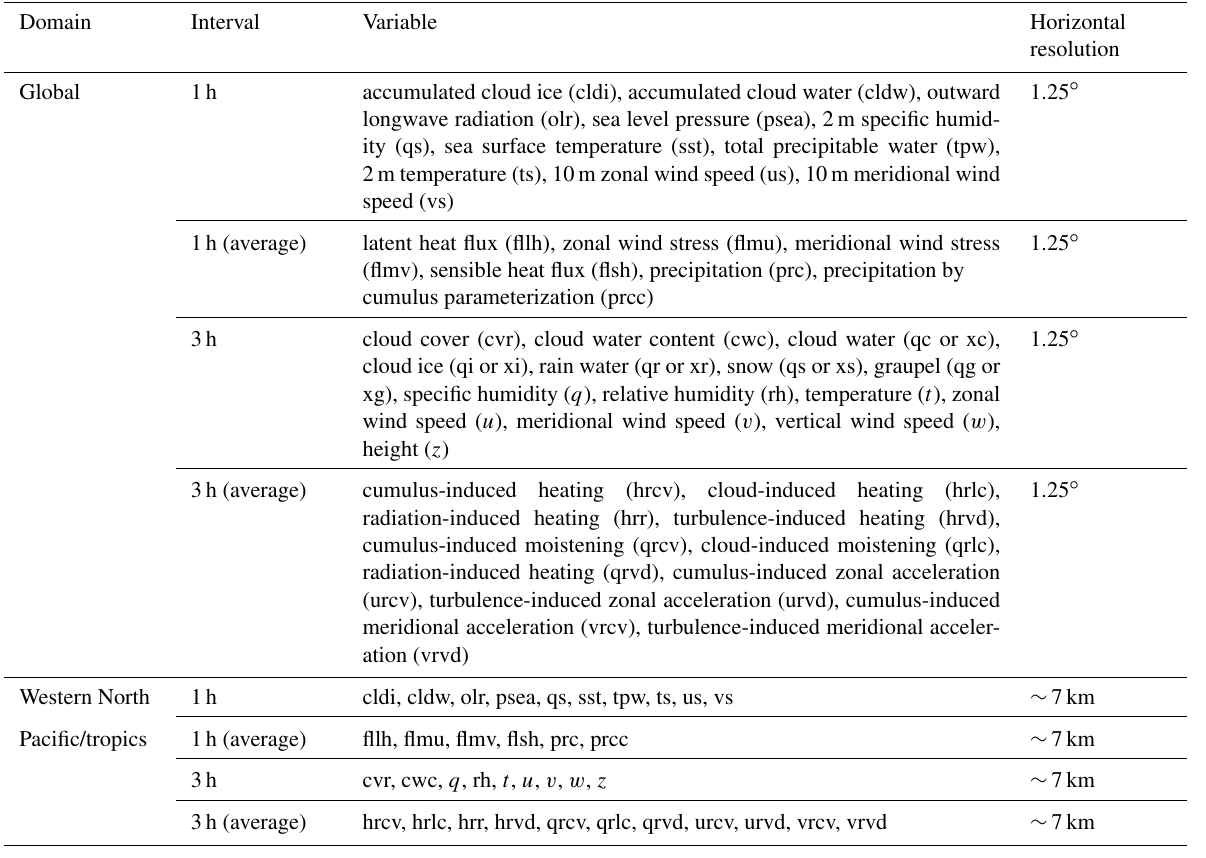
Table 3. Output variables and domains.